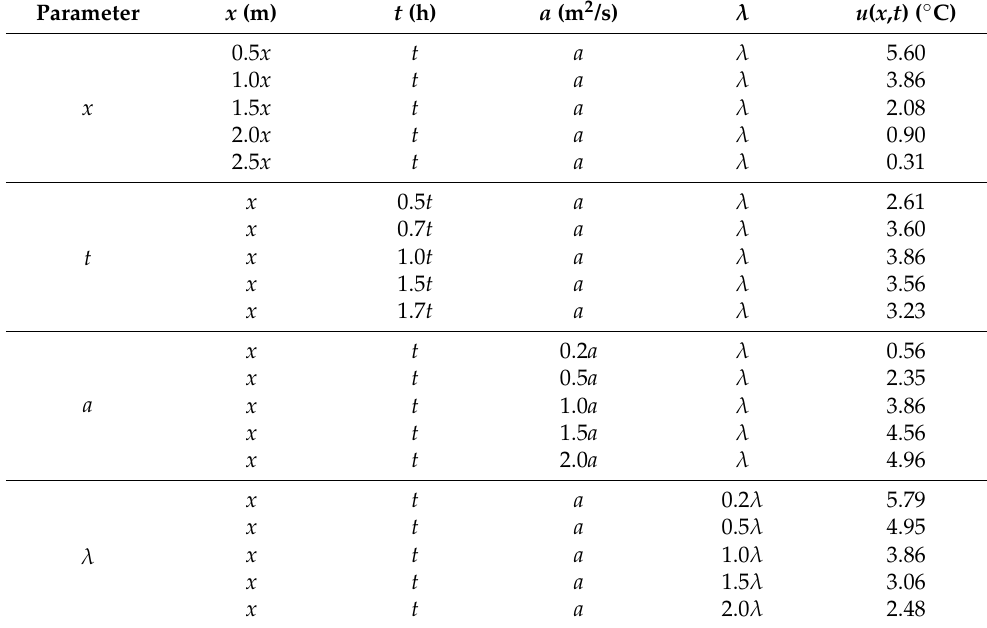
Table 3. Values of the parameters chosen for sensitivity analysis.